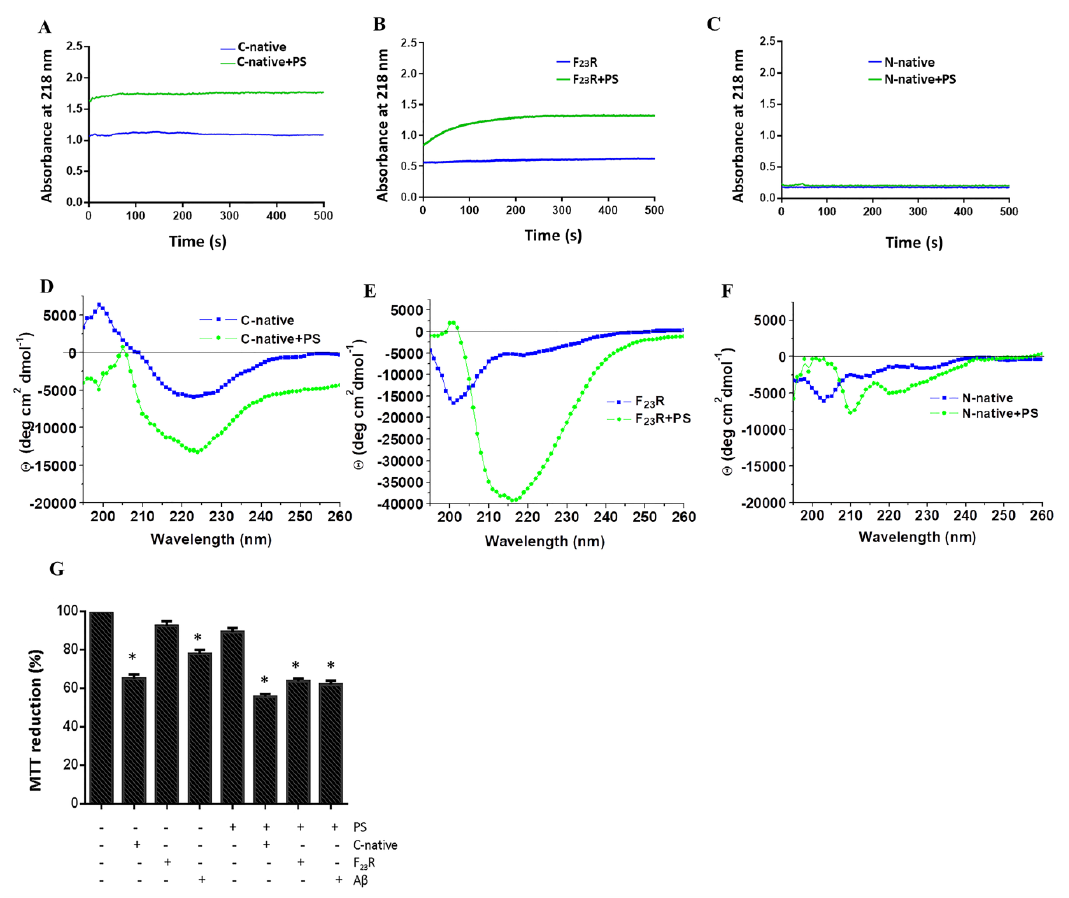
Figure 6. The anionic lipid surface as the critical factor for β -sheet aggregation on C-terminal peptides. E ff ect of PS on nucleation of the C-native segment ( A ), F 23 R variant ( B ), and the N-native segment ( C ). Same experimentation as in A, B, and C, the e ff ect of PS on the secondary structure of the C-native segment ( D ), F 23 R variant ( E ), and N-native segment ( F ), evaluated by CD. ( G ) Cell viability evaluation on RIN-m5F cells treated under di ff erent stimuli of peptides / PS vesicles (7.5 / 15 µ M). Data are expressed as mean ± SD ( n = 6) * p <